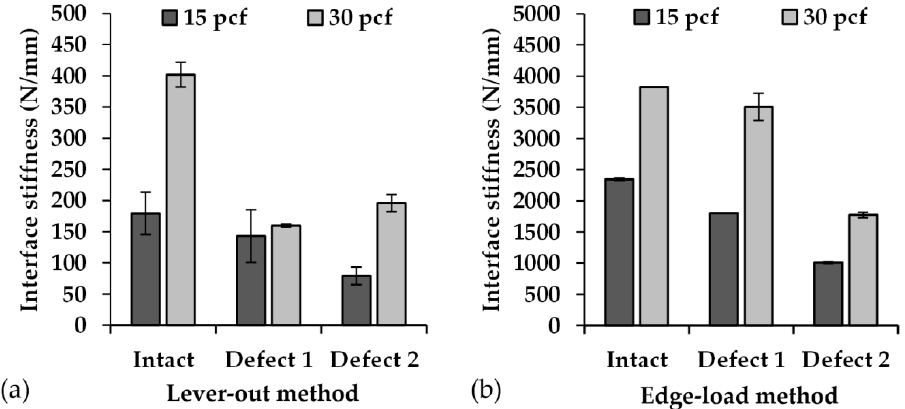
Figure 7. Comparisons of the determined interface sti ff ness of the acetabular cups with regard to a combination of cavity type and foam density for ( a ) lever-out test method (Method 1) and ( b ) edge-load test method (Method 2). The interface sti ff ness are presented as mean values ( n = 3), and the error bars represent the SD. The intact cavity made of 30 pcf foam density tested with Method 2 is the only exception, where only one cup could be tested. For reasons of better visibility, the scaling of both graphs was adjusted to the determined values. Table 3. Tabular listing of the p -values (Welch’s ANOVA with Games–Howell post-hoc test) determined for the parameter Interface sti ff ness k for the various combinations of foam density, cavity type, and test method. The values of p < 0.05 were defined as significant. The group of the intact cavity and 30 pcf foam density for Method 2 was excluded, because the group consisted of only one